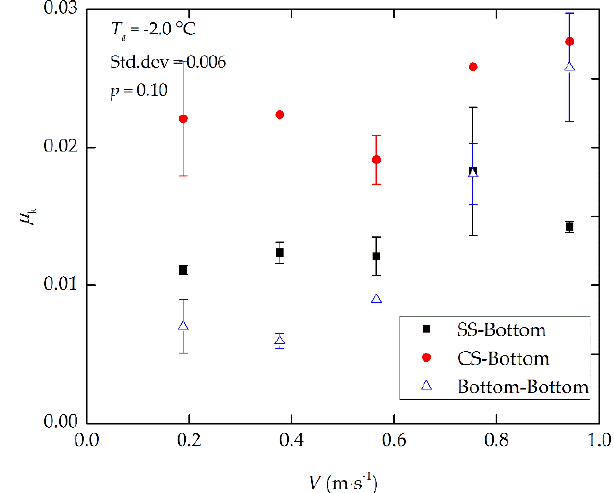
Figure 9. Variations of μ k with velocity V of friction cases of SS, CS, and ice bottom sliding on the Bottom track. The data were averaged over all normal stresses, and the error bars represent the standard deviation. Also shown are the test air temperature, standard deviations of all datasets, and the significance of the rank sum test.